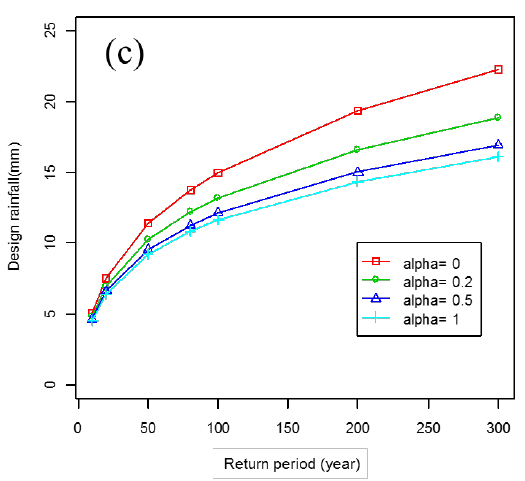
Figure 10. ( a ) GEV (0, 1, 0.2) replacing maximum with an outlier of 8; ( b ) with an outlier of 10; and ( c ) with outlier of 25.